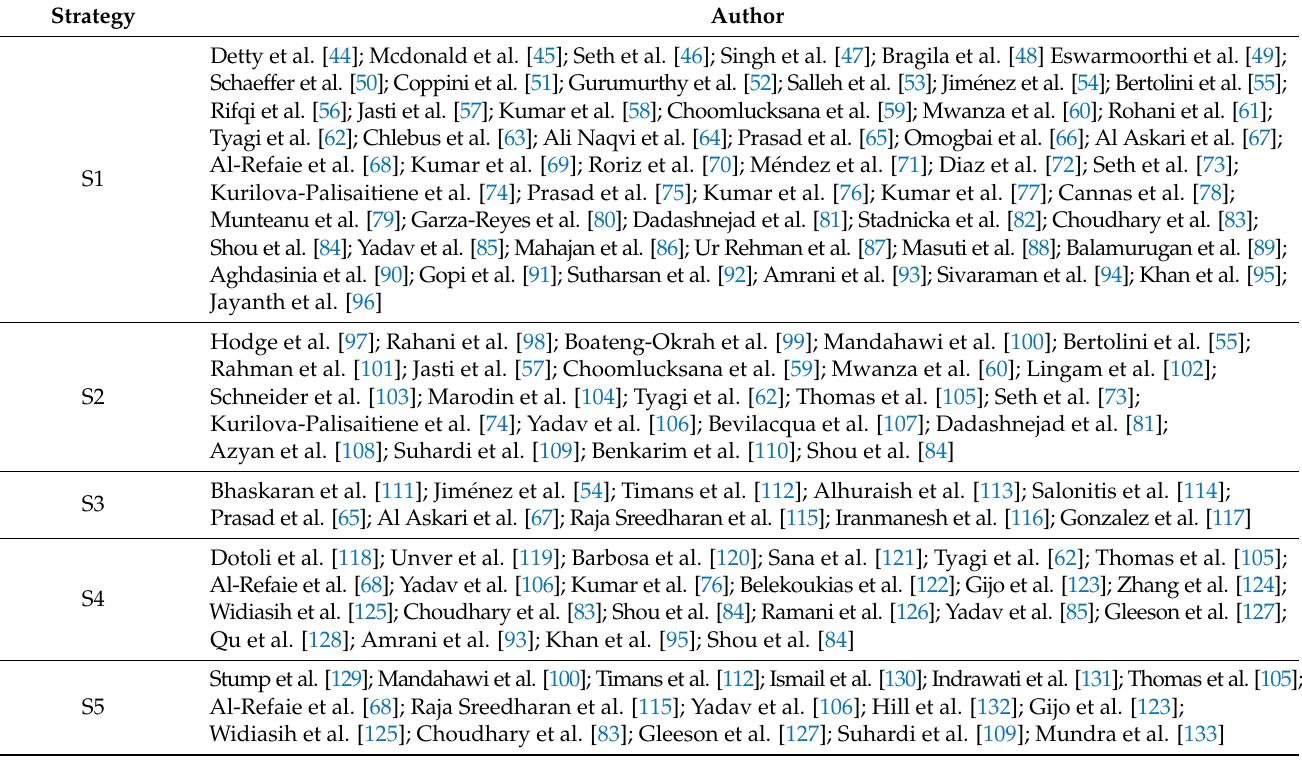
Table 2. A Detailed description of the strategies implemented in previous research